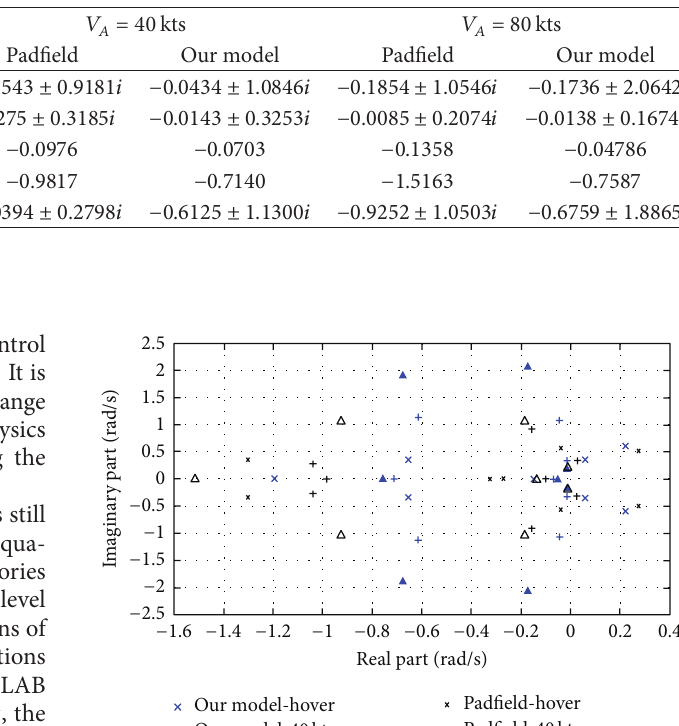
Table 1: Flight dynamics modes comparison.